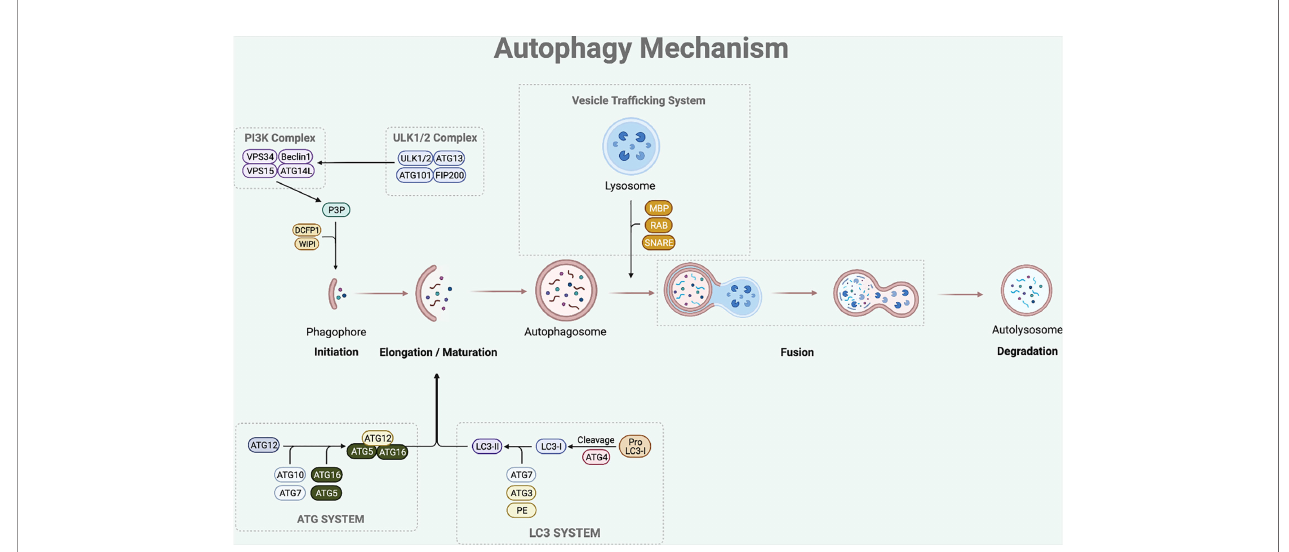
FIGURE 1 | Autophagy Mechanism. The autophagy process involves multi-steps which are initiation, elongation, maturation, fusion and degradation. The initiation step of mammalian autophagy involves the ULK complex (consisting of ULK1/2, ATG13, FIP200, and ATG101). The ULK complex phosphorylates Beclin1 to activate PI3K complex (composed of Beclin1-VPS34-VPS15-ATG14L). The PI3K complex then induces P3P formation, which recruits DCFP1 and WIPI for autophagosome formation. During the elongation and maturation stage, ATG7 and ATG10 help to conjugate the ATG12 to ATG5, forming an ATG5-ATG12 complex. This complex then interacts with the ATG16 to form an ATG16-ATG5-ATG12 complex that is involved in elongation and maturation of the autophagosome. LC3-I is formed by the proteolysis of pro-LC3 by ATG4. The ATG3 and ATG7 conjugate LC3-I to PE to form LC3-II that inserts into the autophagosome membrane. After the elongation and maturation, autophagosome with target cargo is traf fi cked to the lysosome to fuse and form an autolysosome. This process is regulated by RAB protein family, SNARE protein family, and MBP. The autolysosome then releases acidic hydrolase to degrade the inner content and the degraded cargo is released back to the cytoplasm to be reused for cellular